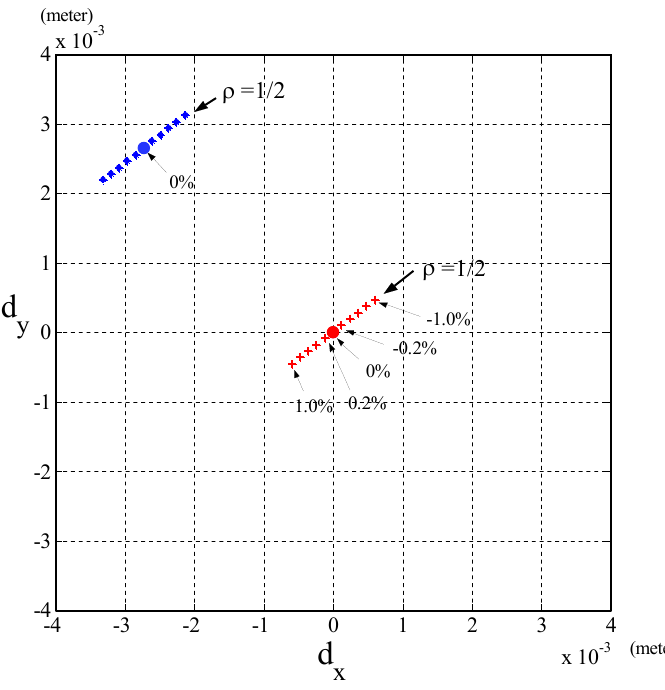
Figure 4. Simulation results of the Cartesian position errors of the end-effector of a